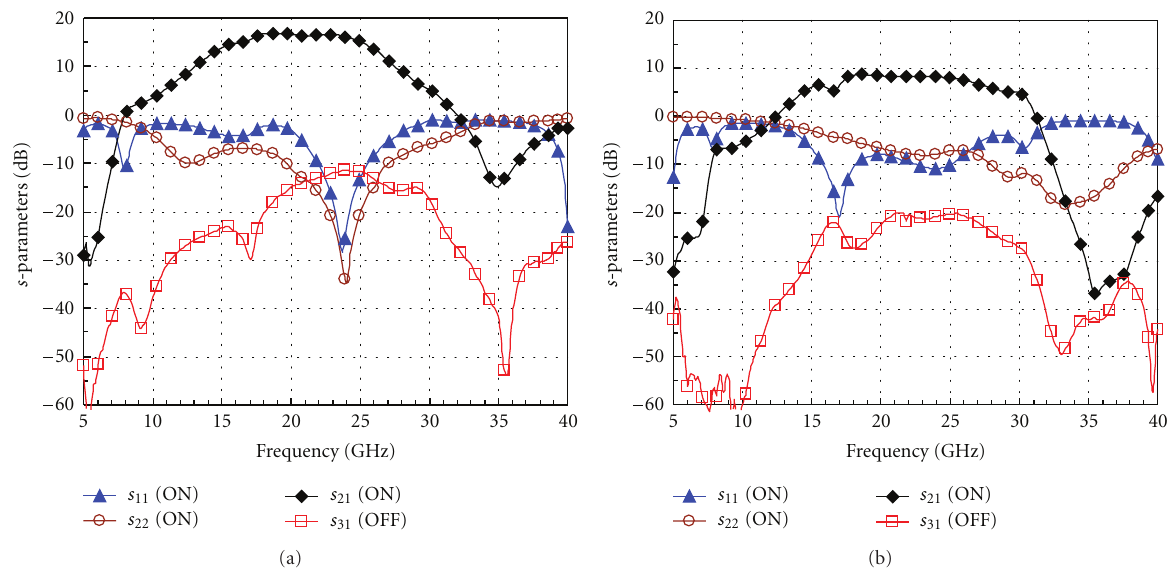
Figure 8: Measured s -parameters of the RF-MEMS reconfigurable (multifunctional) dual-path LNA hybrid circuit: (a) LNA1 switched ON (LNA2 OFF) and (b) LNA2 switched ON (LNA1 OFF).